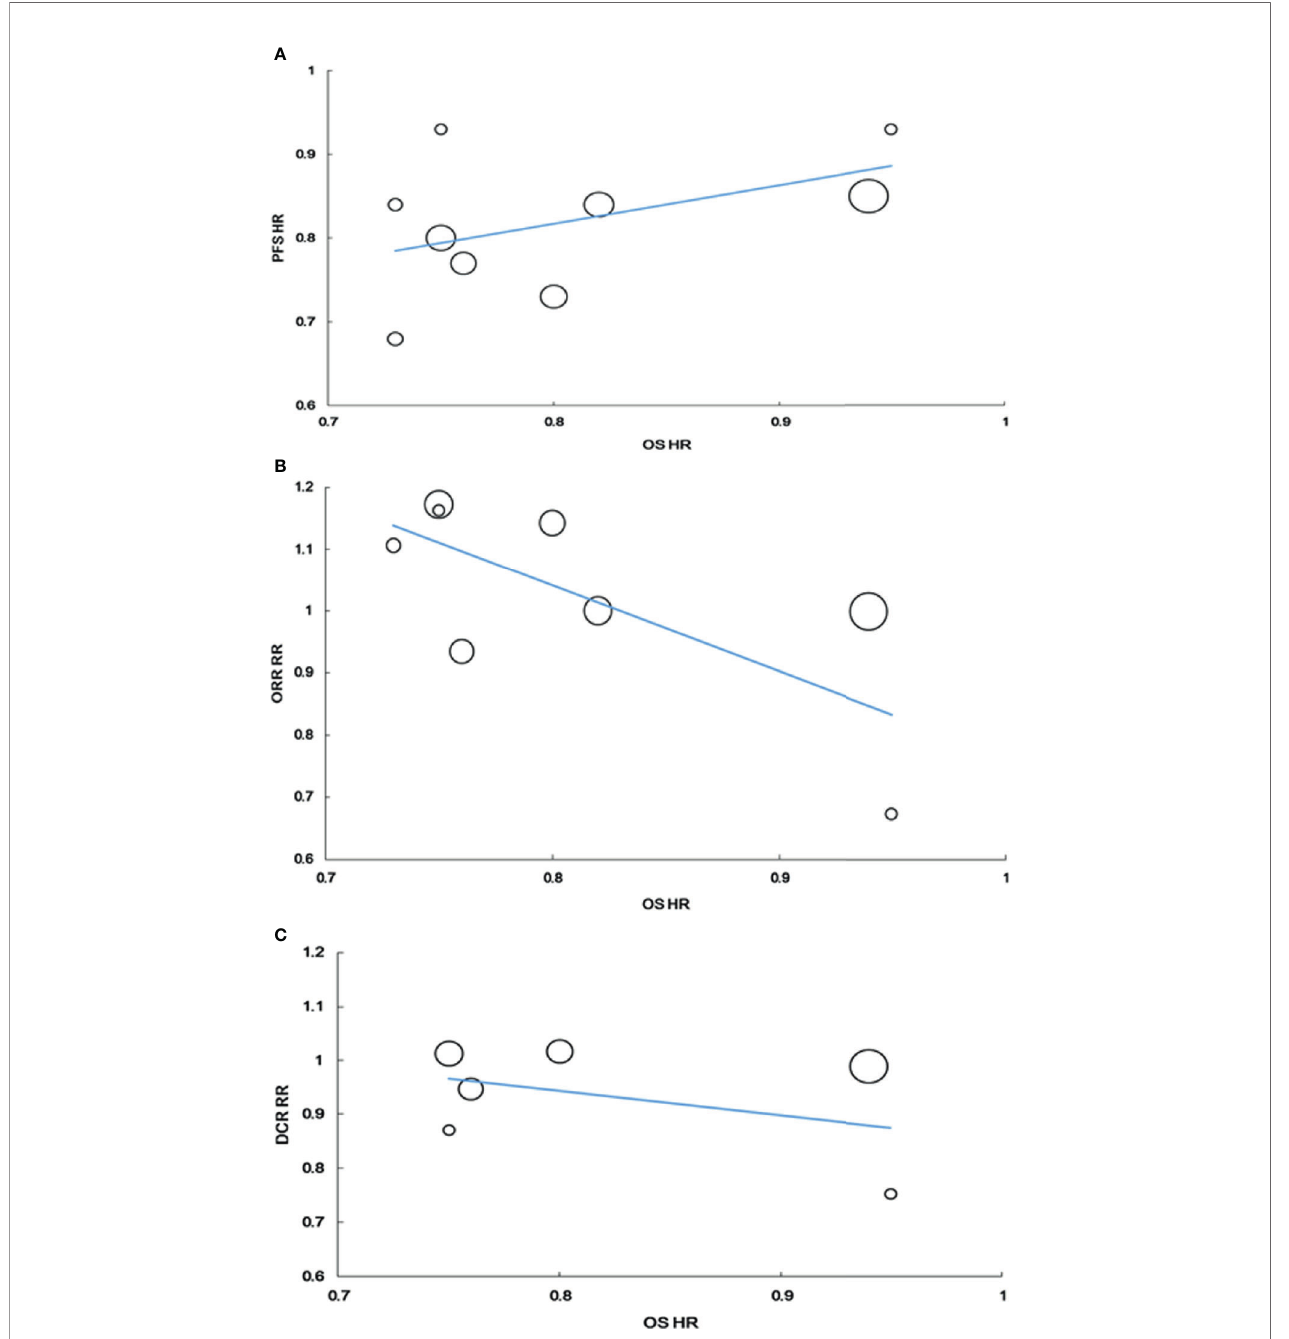
FIGURE 5 | Correlation of treatment effects on the overall survival (OS) hazard ratio (HR) with the PFS HR (A) , with the RR of ORR (B) , with the RR of DCR (C)